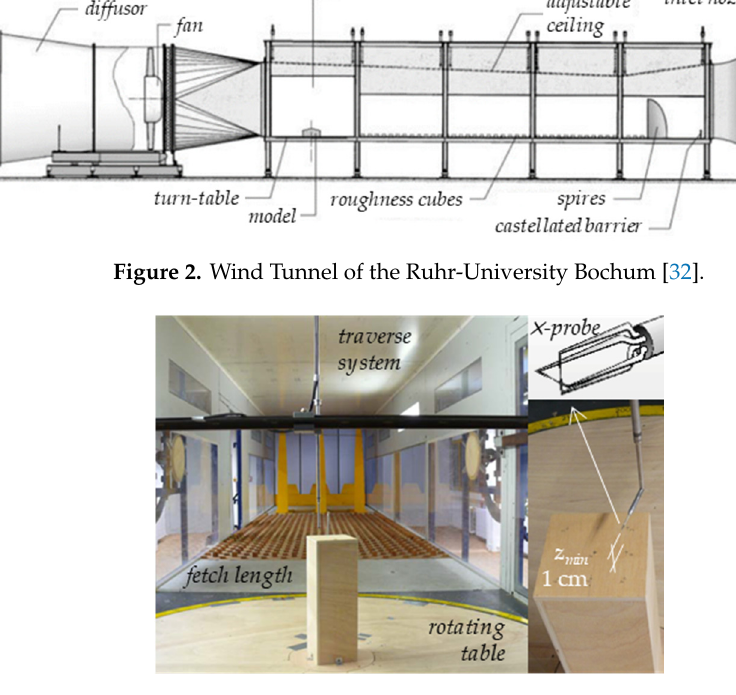
Figure 3. Photo of the wind tunnel with the model mounted on a turning table.